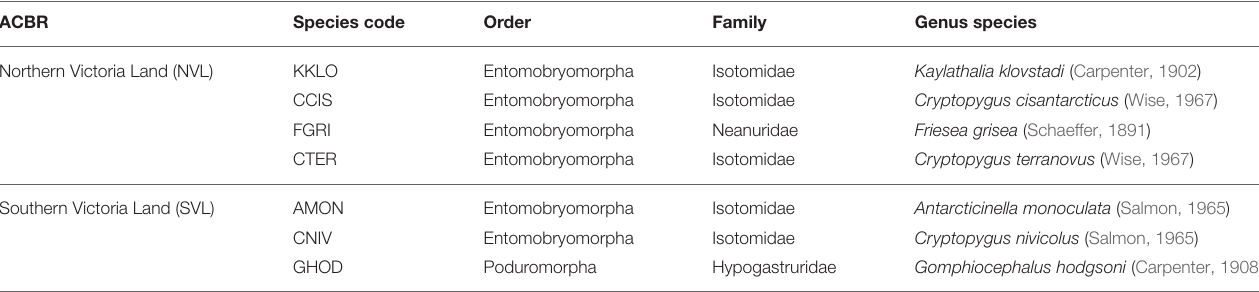
TABLE 1 | The seven springtail species present in the two Antarctic Conservation Biogeographic Regions (ACBRs) in Victoria Land (NVL and SVL), within the Ross Sea sector of Antarctica.